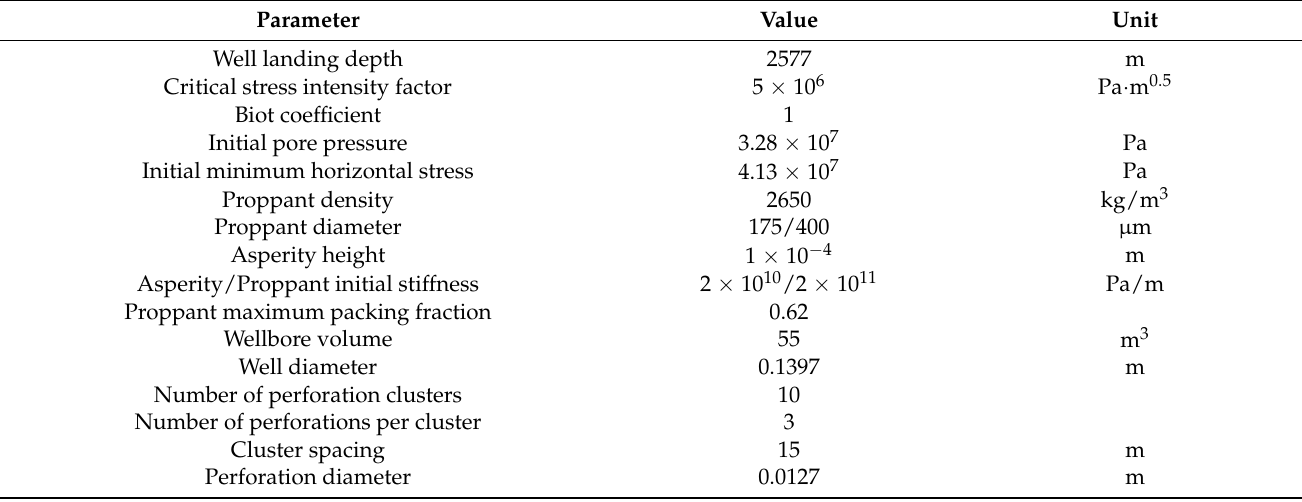
Table 5. Other key input parameters of the simulation.